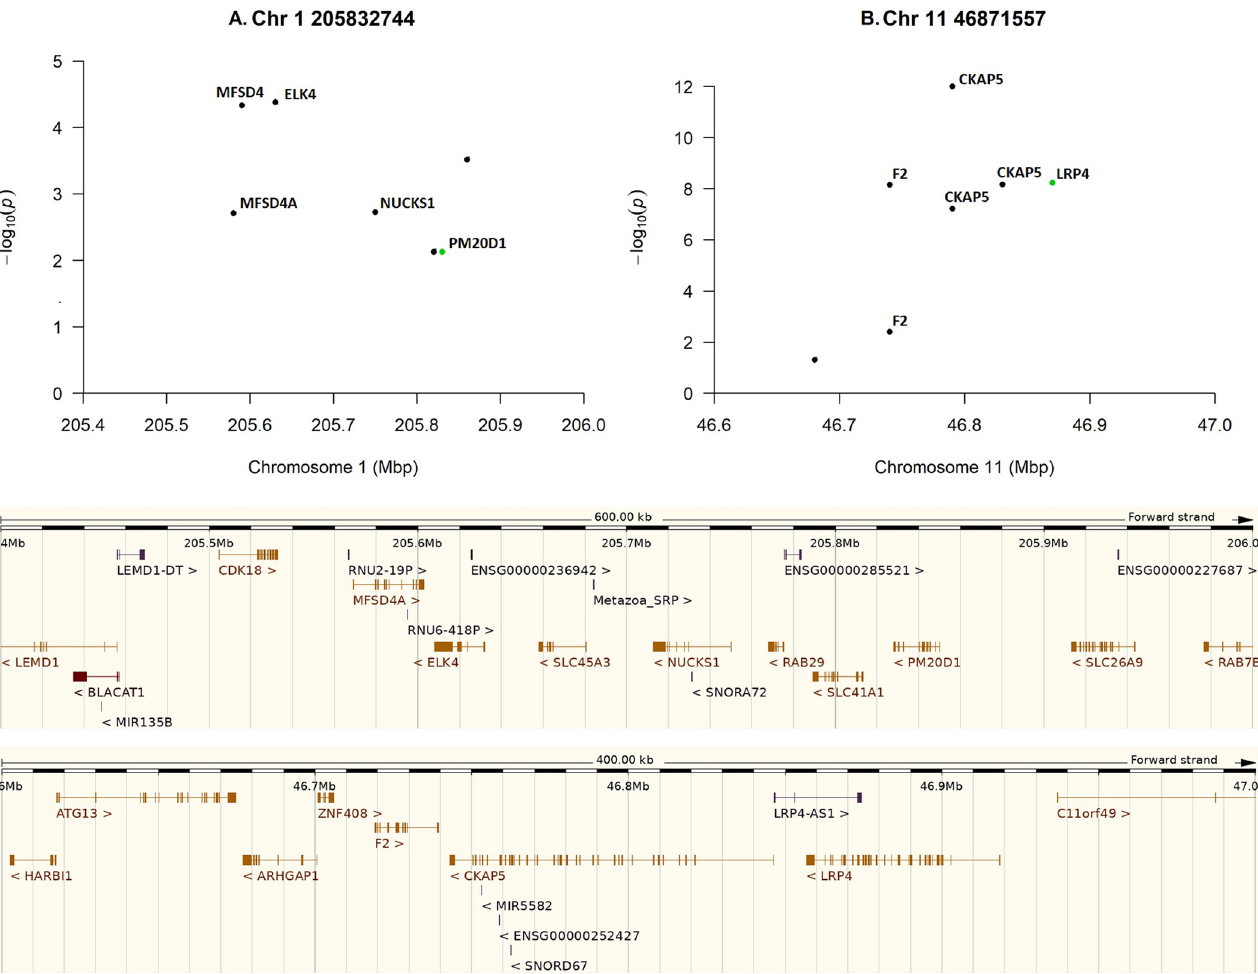
Fig 4. Genomic regions that correspond to the location of two missense SNPs with a potential causal function on a severe outcome of COVID–19, with green dots representing the missense SNPs in severe (A) and resistant (B) phenotypes.